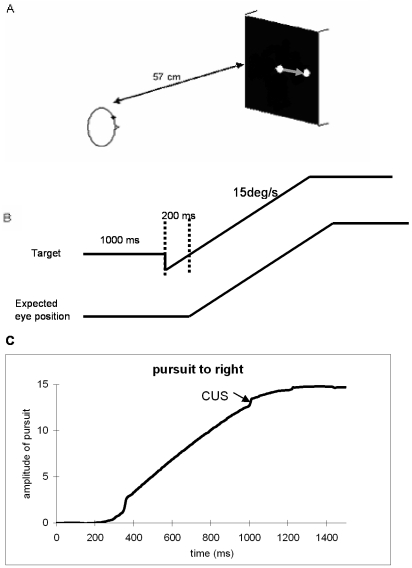
The smooth pursuit task.(A) Spatial arrangement for smooth pursuit: one white dot on the black computer screen, 57 cm from subject's eyes, moving from center to right or left (15°), randomly. (b) Temporal arrangement: the white dot moves to opposite direction to the pursuit then returns to center (200 ms) to begin pursuit, the stimulus at velocity of 15°/s. (c) Typical recording of normal rightward pursuit is obtained by averaging the position signal of the two eyes (LE+RE)/2; CUS indicates catch-up saccades during the pursuit.